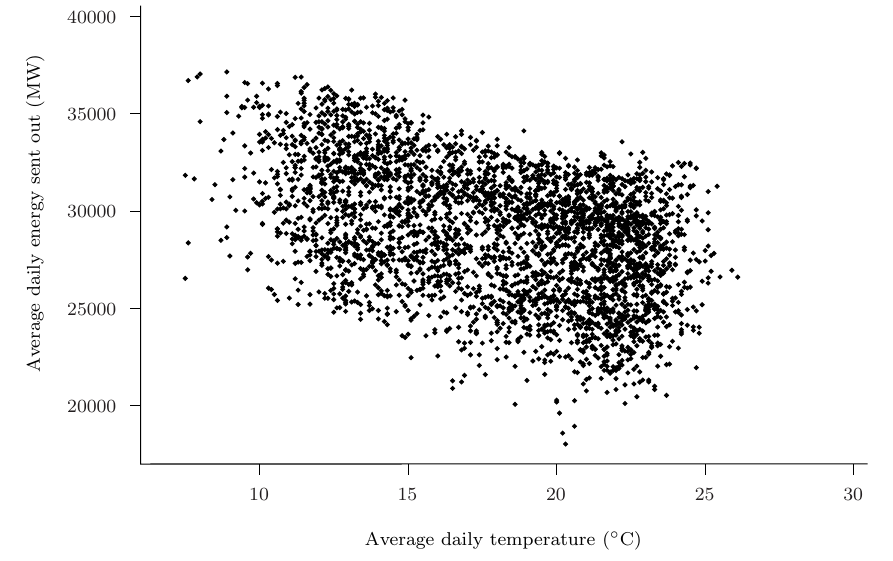
Figure 6: Scatter plot of average daily energy sent out against average daily temperature. is shown in Figure 7. The modelling space is divided into three subspaces, separated by two knots at 16 ◦ C and 22 ◦ C, as shown in Figure